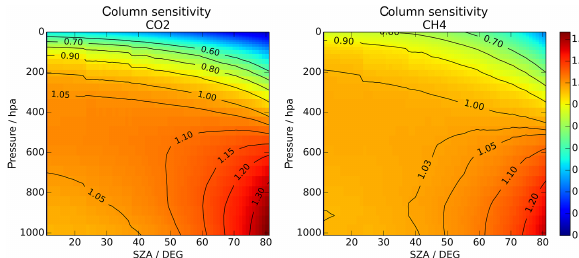
Figure A1. Retrieval total column sensitivity of the target species in dependence of the layer pressure and solar zenith angle (SZA). The data are averaged over three consecutive campaign days (24 March, 31 March and 8 April). The figures can be interpreted as the factor that the total column product will be enhanced, if one additional molecule would be added to a distinct pressure